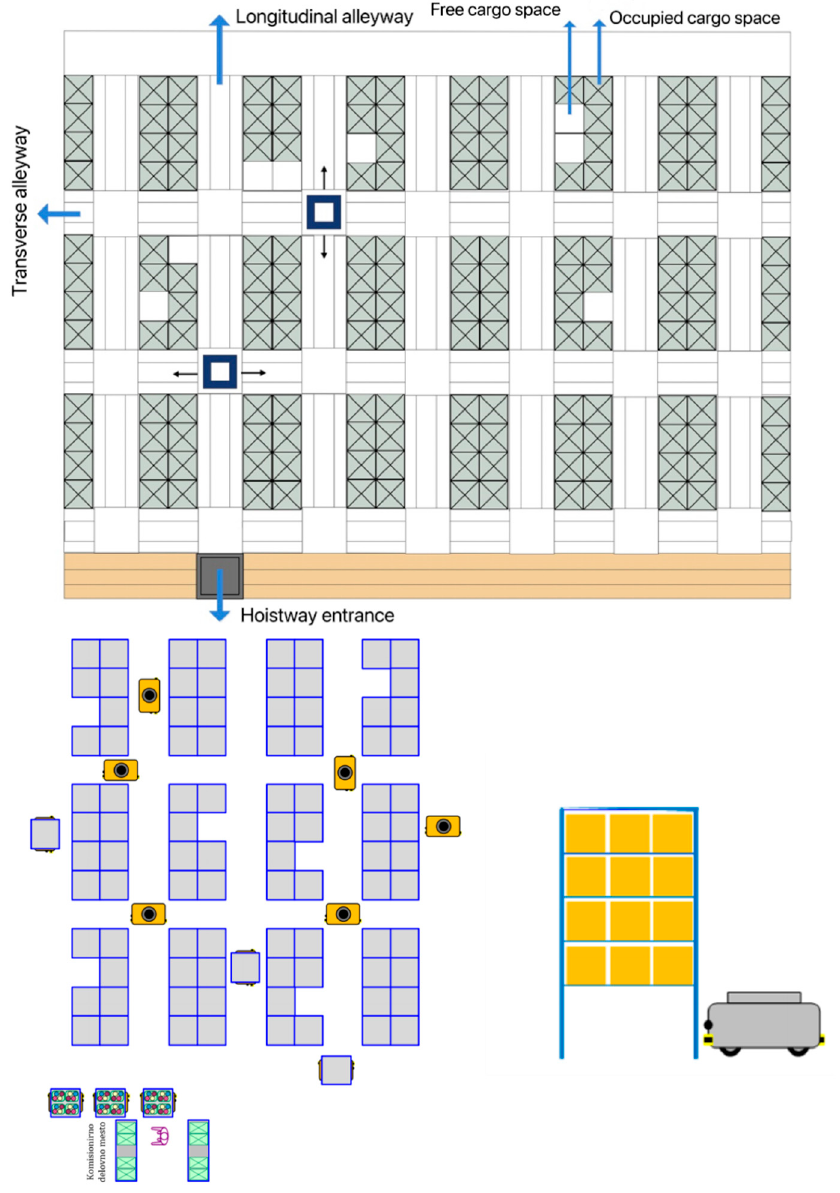
Figure 1. Schematic diagram of a four-way shuttle system .